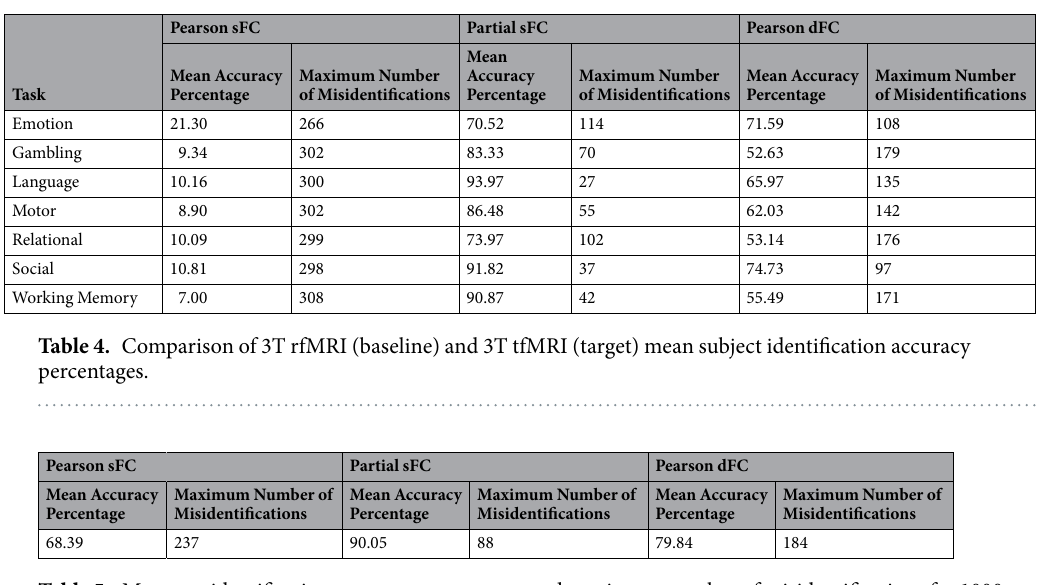
Table 5. Mean sex identification accuracy percentages and maximum number of misidentifications for 1000 program